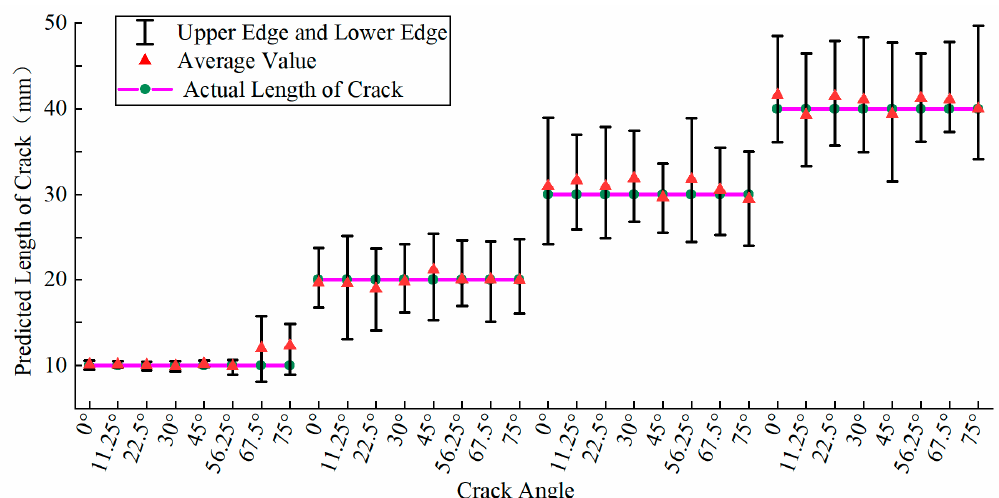
Figure 13. Length prediction of cracks at different angles (MIMO-BPNN).